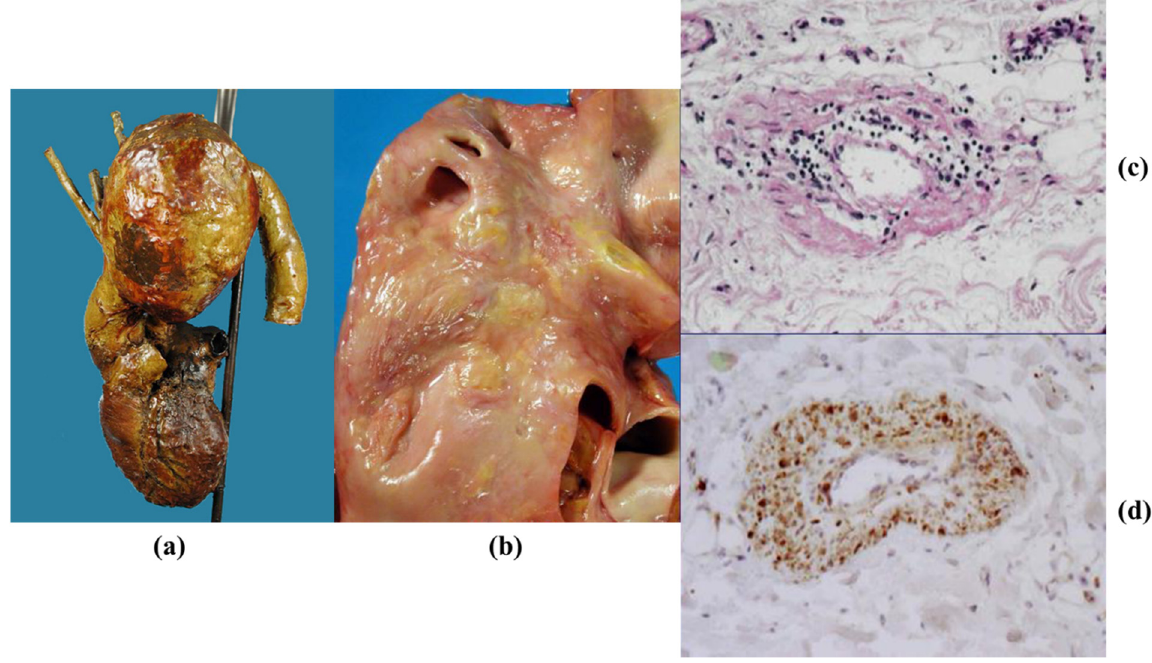
Figure 23. ( a ) Huge saccular syphilitic aneurysm of the aortic arch (from the Morgagni Museum of the Institute of Pathological Anatomy, University of Padua, with permission). ( b ) Syphilitic ascending aorta with pavement-like appearance of the intima. ( c , d ) Plasma cell inflammatory infiltrates in the obstructed vasa vasorum. (Hematoxylin-eosin and anti-CD79 immuno stain).